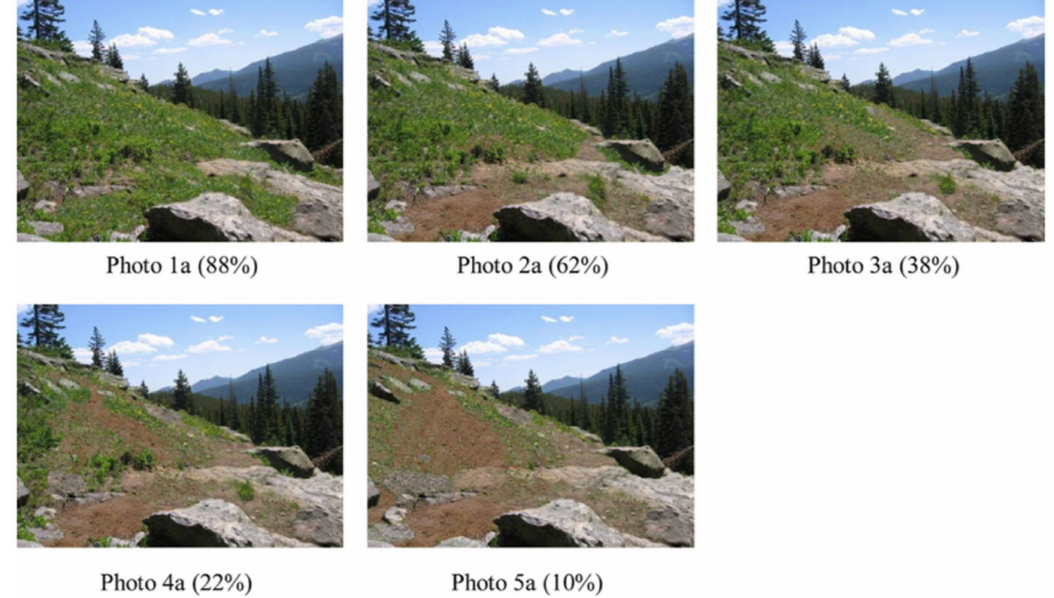
Figure 2. Hillside scenes with increasing vegetation loss / development of a visitor-created site. Percentiles represent vegetation cover